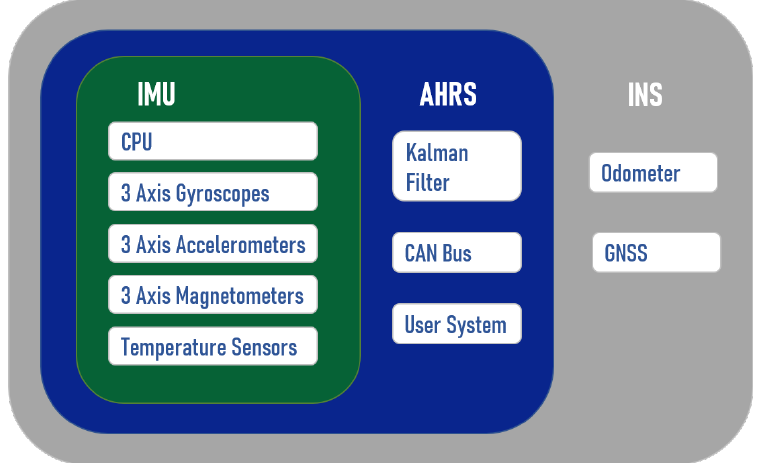
Figure 5. IMU, AHRS, INS and structural diagram of their functions from SBG Systems company. Adapted from